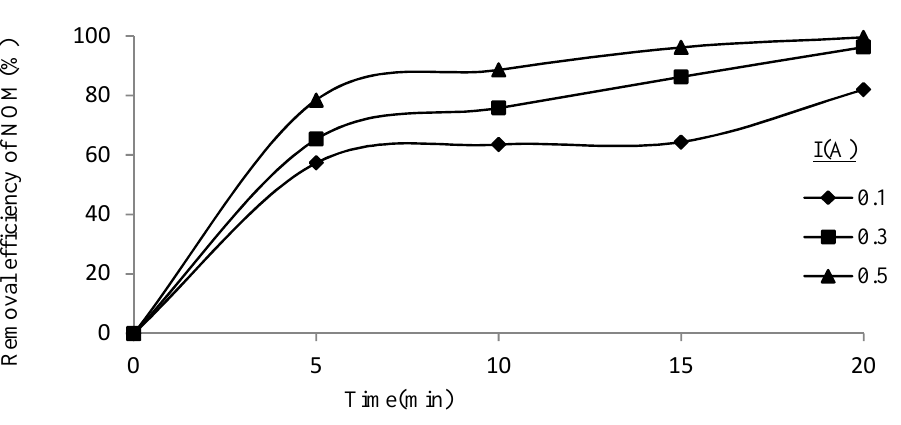
Figure 3. The relationships between natural organic matter (NOM) removal efficiencies with the current changes and reaction time (conditions: neutral pH, initial NOM concentration of 50